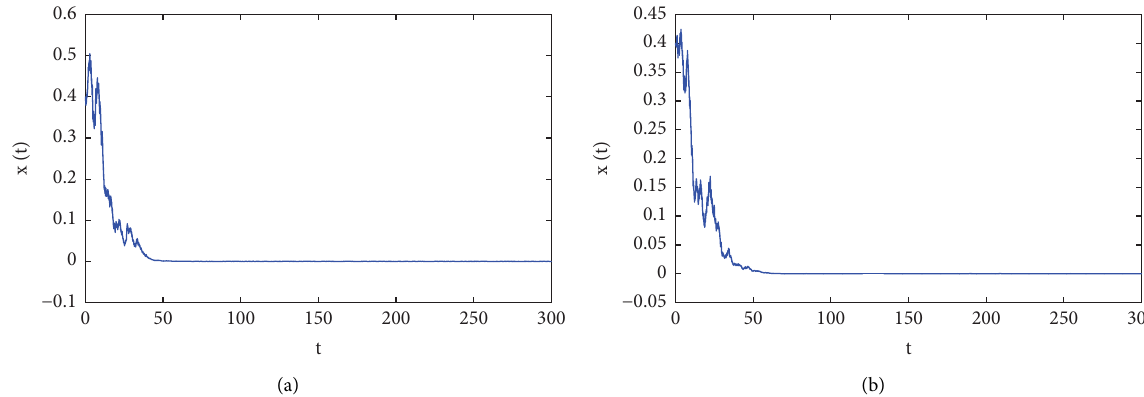
Figure 4: Te lines represent the solution of model (8) for r ( t ) � − 0 . 01 + 0 . 2sin t, K � 1, initial data x C � 0 , a ( t ) � 0 , σ ( t ) � 1 , c ( u ) � − 0 . 05; (b) C � 1 , a ( t ) � 0 . 1 , σ ( t ) � 1 , c ( u ) � − 0 . 05.